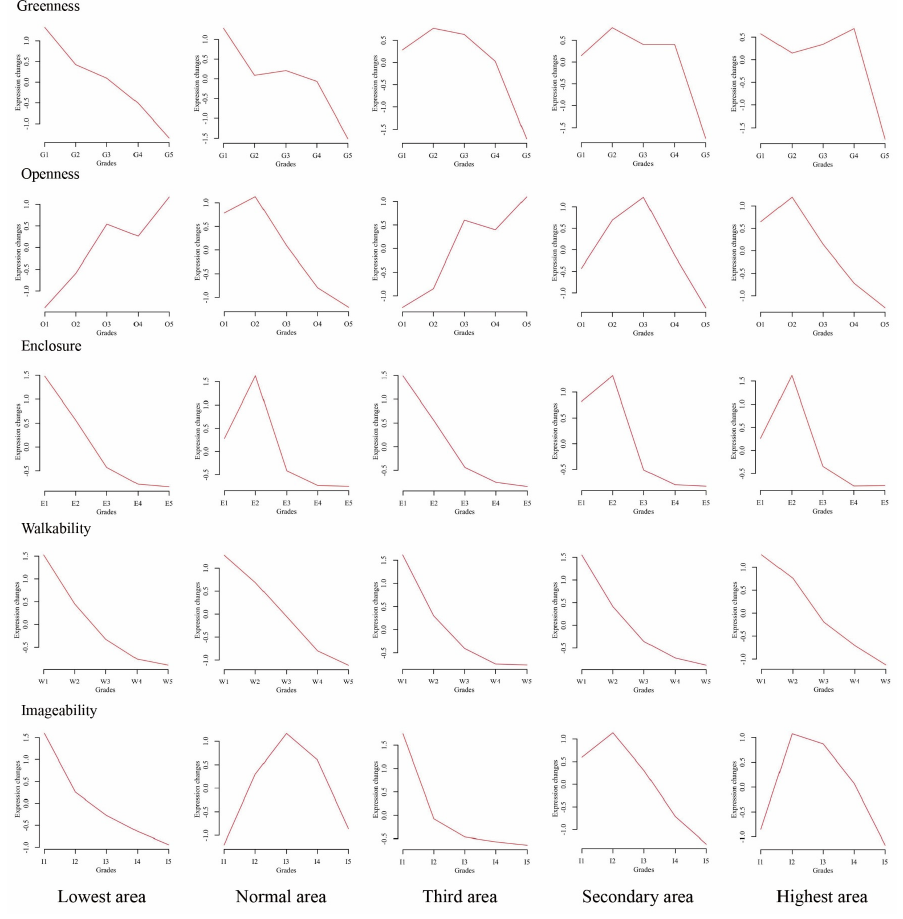
Figure 13. Cluster trends of different human activity densities.